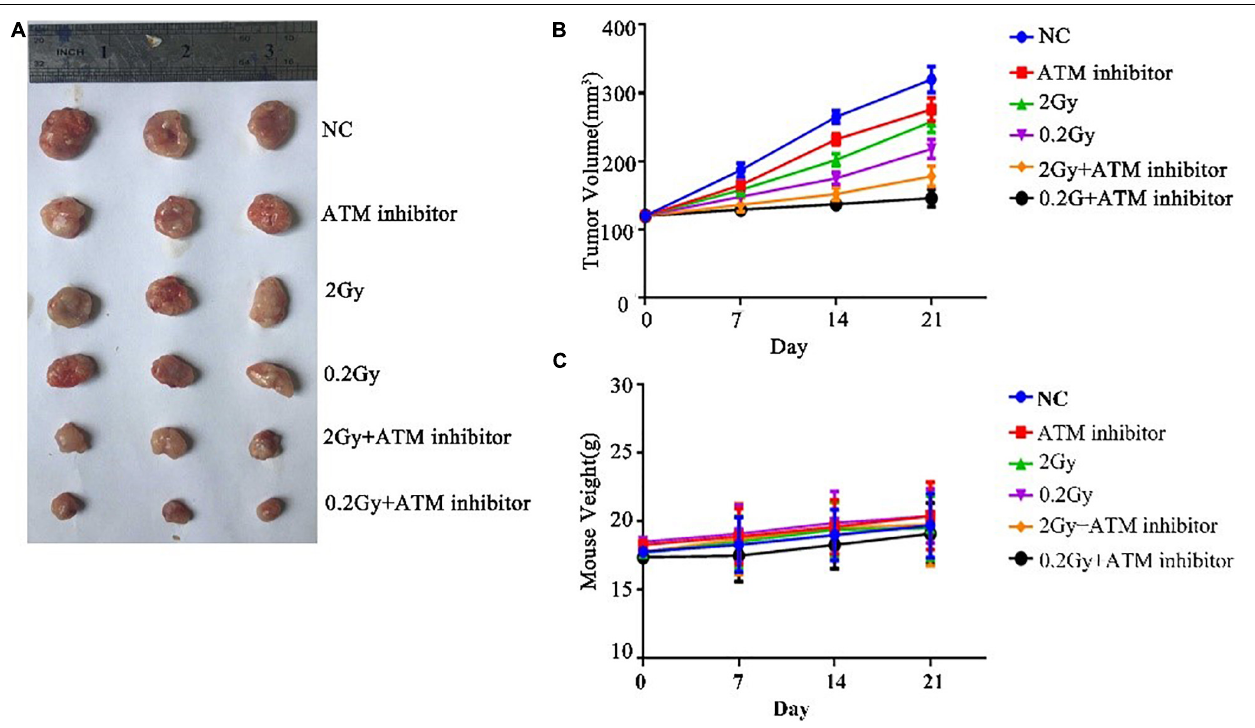
FIGURE 7 | The effect of ATM on tumor growth under low-dose irradiation. (A,B) Effects of different treatment conditions on tumor xenograft volume in nude mice. (C) Effects of different treatment conditions on the body weight of nude